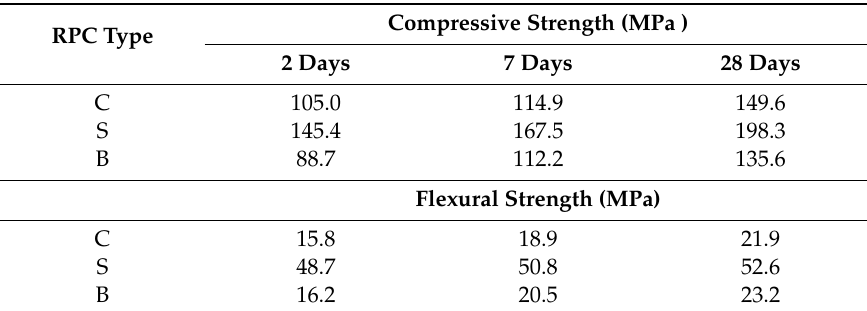
Table 5. Results of the compressive and flexural strength tests of RPC (MPa).